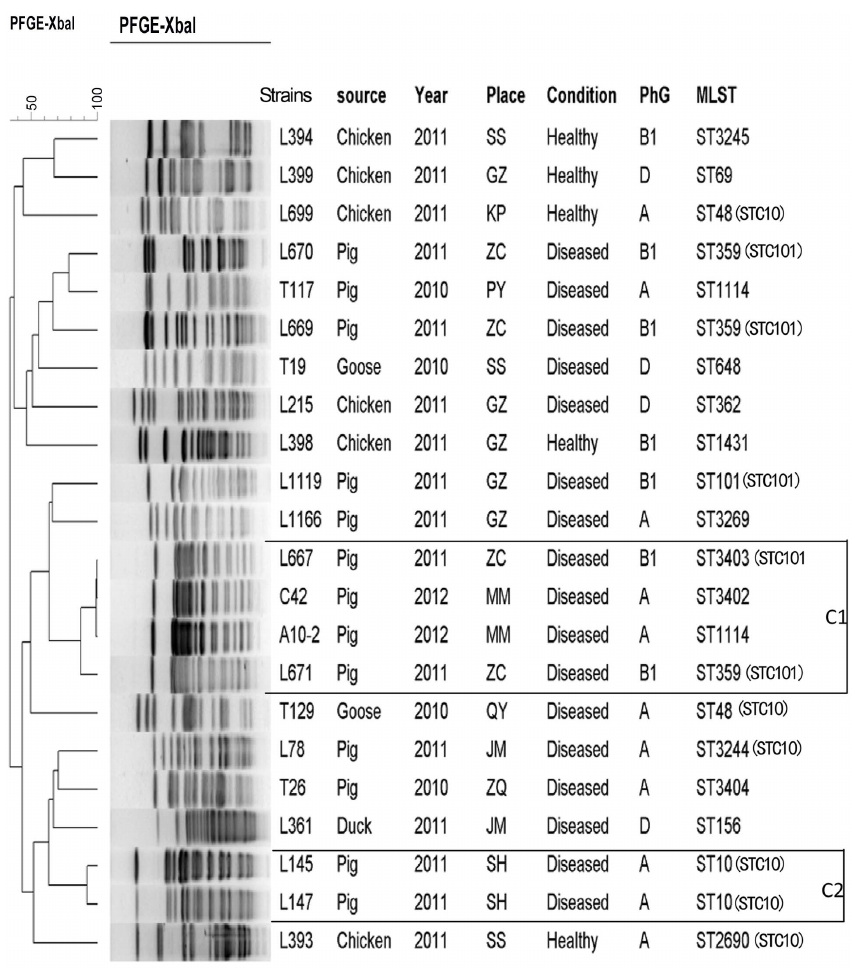
Figure 1. Dendrogram of Xba I-PFGE patterns of CMY-producing E.coli strains recovered from food-producing animals. All the strains were CMY-2 producers, except for T19 (CMY-41) and T129 (CMY-64). Similarity analysis was performed using the Dice coefficient, and clustering was performed by following the unweighted-pair group method using average linkages (UGPMA). A total of 16 PFGE patterns were identified, and the two clusters with highly similar PFGE patterns were labeled C1 and C2. Abbreviations for the place column: SS, Sanshui; GZ, Guangzhou; KP, Kaiping; ZC, Zengcheng; PY, Panyu; MM, Maoming; QY, Qingyuan; JM, Jiangmen; ZQ, Zhaoqing; SH, Sihui. Abbreviation for PhG: Phylogenetic Group.